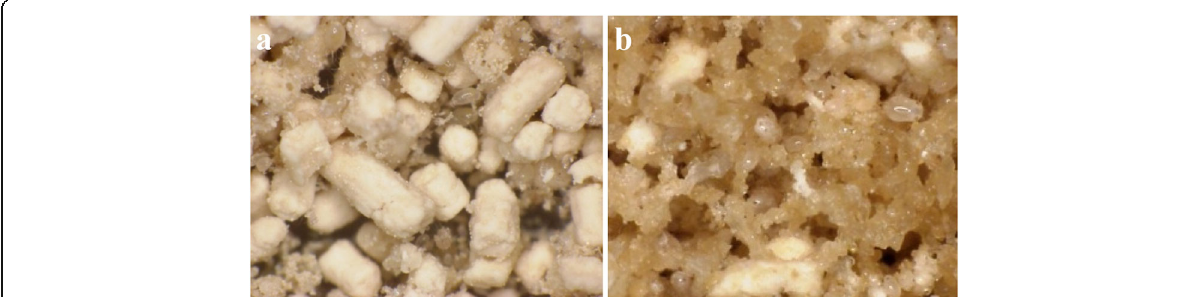
Fig. 1 Rearing medium for the predatory mite, Amblyseius swirskii, and food for its prey, dried fruit mite, Carpoglyphus lactis . a Baker ’ s yeast (and C. lactis ) and b Brown sugar and baker ’ s yeast mixture (and C. lactis